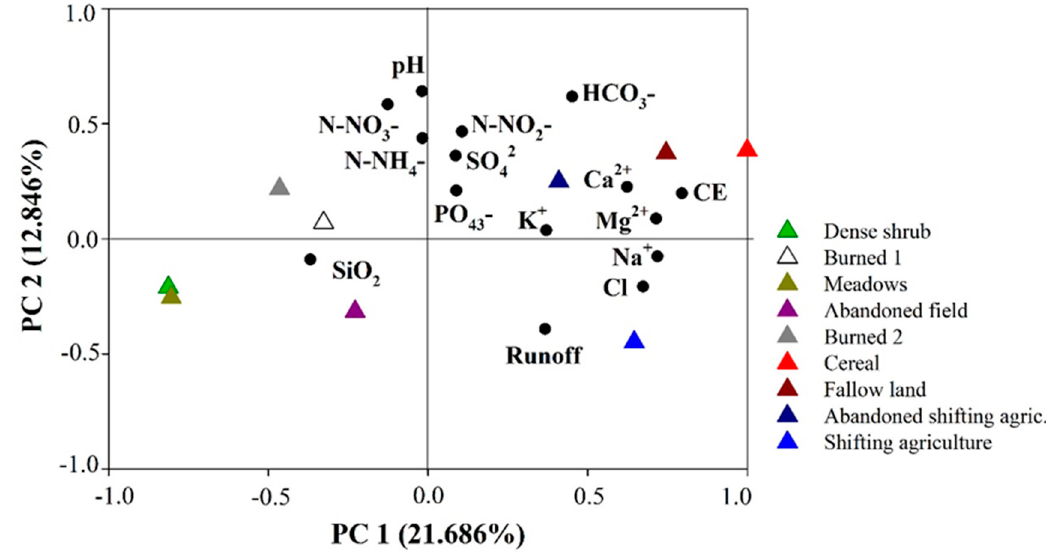
Figure 6. Eigenvectors from the principal component analysis (PCA) and PC scores plotted in the plane of the first two components.